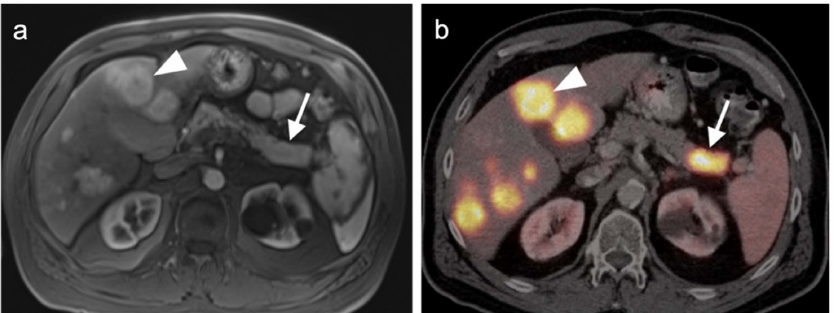
Figure 39. Comparison between MRI and SSTR PET-CT in the detection of primary pancreatic neuroendocrine tumor and hepatic metastases. ( a ) Axial Gd-enhanced T1 FS MRI image of the upper abdomen demonstrates increased signal in multiple hepatic metastases (white arrowhead) and in the primary lesion in the tail of the pancreas (white arrow). ( b ) Axial [ 68 Ga]Ga-DOTA-TATE PET-CT through the same regions shows intensely PET-positive lesions in the liver (white arrowhead) and the tail of the pancreas (white arrow), with similar detection to